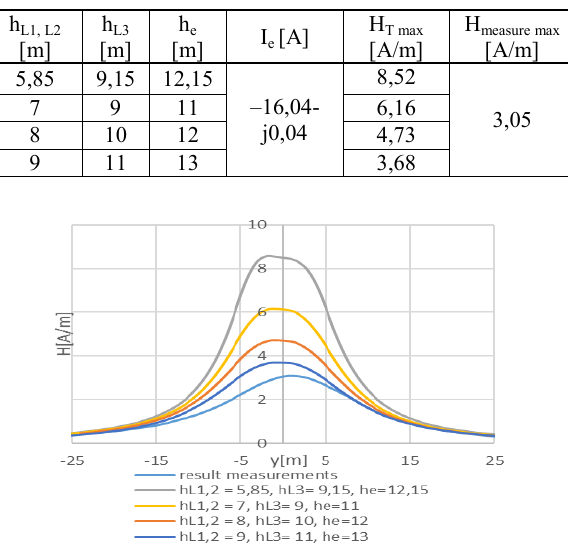
Fig. 3. Magnetic field strength charts - comparison of measurements with calculation